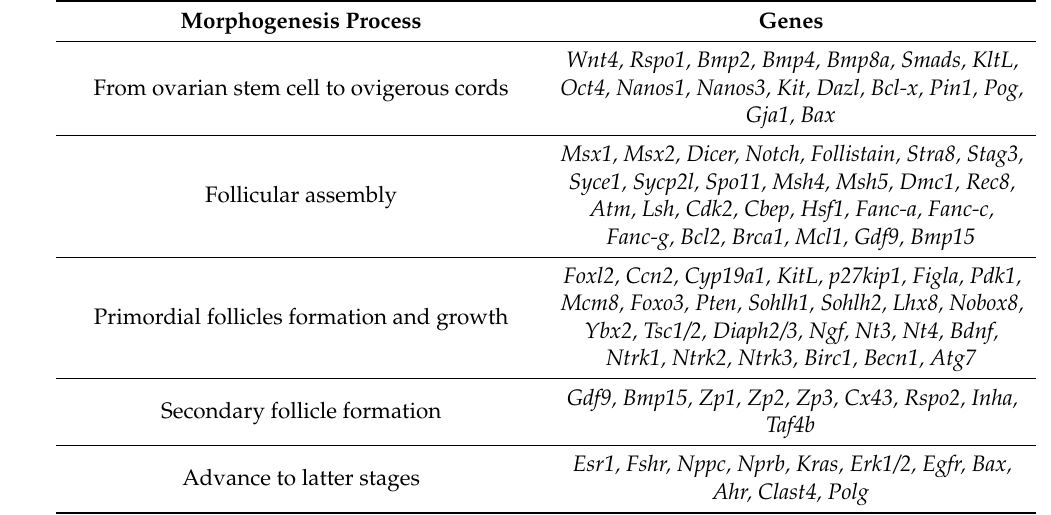
Table 1. Follicular development process and related genes.